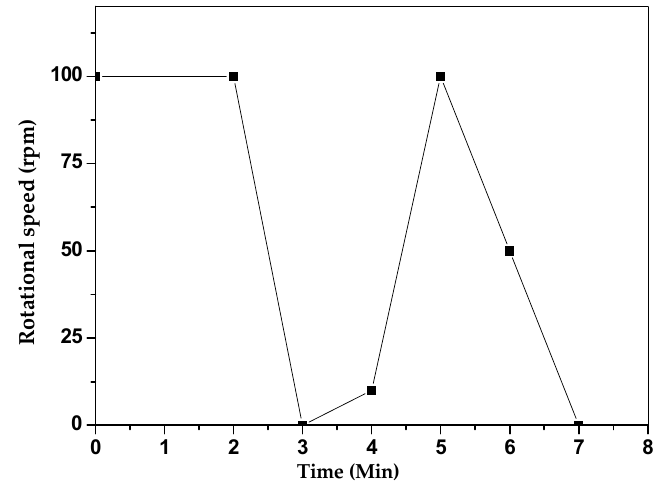
Figure 2. Ramp speed time profile for Viskomat NT rheometer .